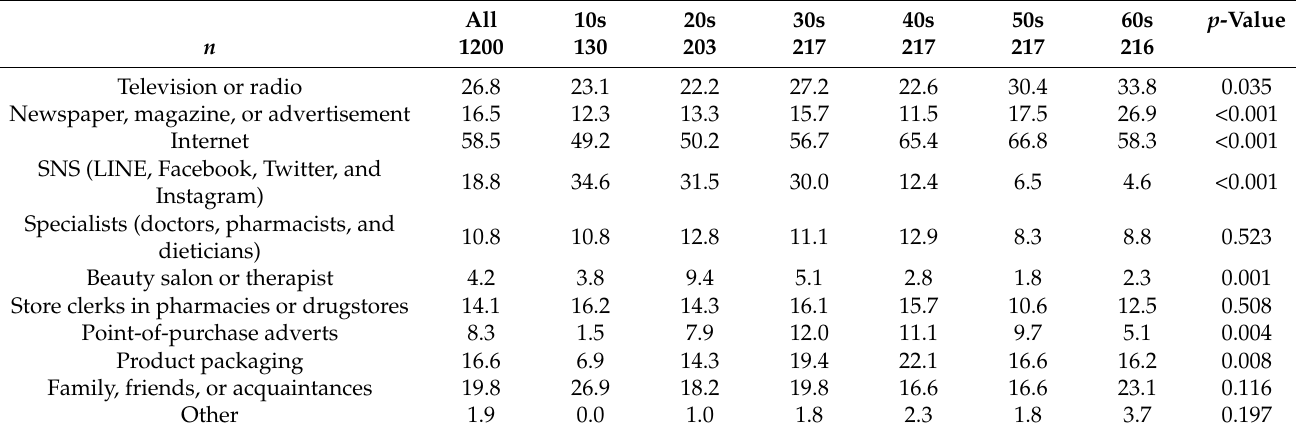
Table 11. Information sources of estrogen-like